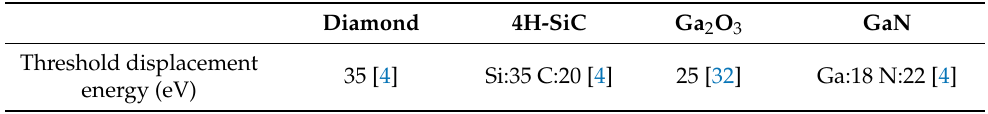
Table 2. Threshold displacement energy for diamond, 4H-SiC, Ga 2 O 3 and GaN. Reference to source is shown in square